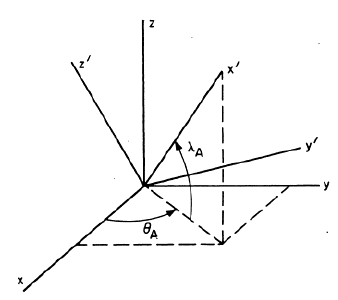
Figure 5. Relationship of x, y, z and x’, y’, z’ coordinate axes.